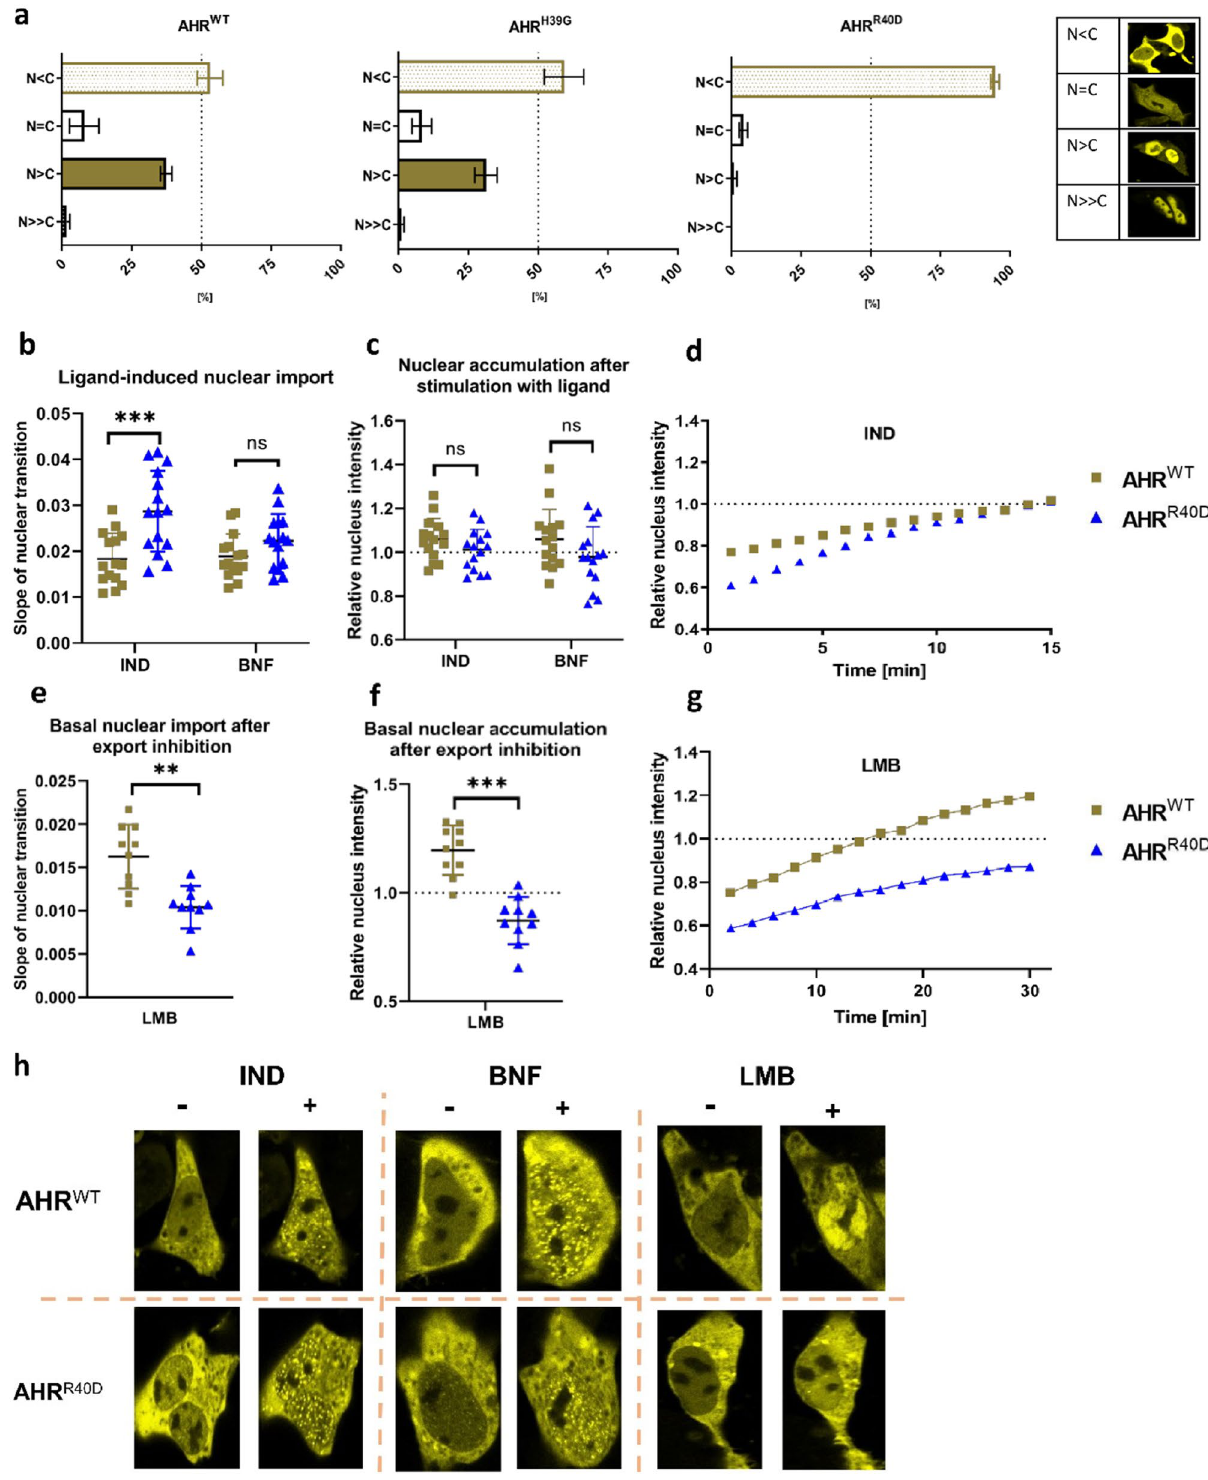
Figure 3. The DNA-binding motif determines the intracellular distribution of the AHR through the overlap with the second nuclear localization signal (NLS). ( a ) Distribution of the EYFP-tagged AHR and AHR mutants in HepG2 cells are shown. More than 300 cells were randomly selected and classified according to the given distribution pattern. Data represents mean ± S.D from three biological replicates. ( b , e ) Slopes of nuclear transition the AHR WT and AHR R40D (Arg → Asp) after treatment with 10 µM indirubin (IND), 10 µM β-naphthoflavone (BNF) or 200 nM leptomycin B (LMB). ( c , f ) Nuclear accumulation of the AHR WT and AHR R40D 15 min or 30 min after treatment with IND, BNF or LMB, respectively. Individual values and the mean ± S.D. of 15 ( b , c ) or 10 ( e , f ) cells are presented (two way ANOVA, Dunnett’s multiple comparisons test, *** p < 0.001). ( d , g ) Representative measurements of time-lapse experiments after stimulation with IND ( d ) or LMB ( g ) of indicated AHR variants in HepG2 cells. Relative nuclear intensity denotes the intensity of the nucleus against the intensity of the entire cell. ( h ) Representative images of HepG2 cells transfected with AHR WT or AHR R40D before and after 15 min of treatment with IND, BNF, and